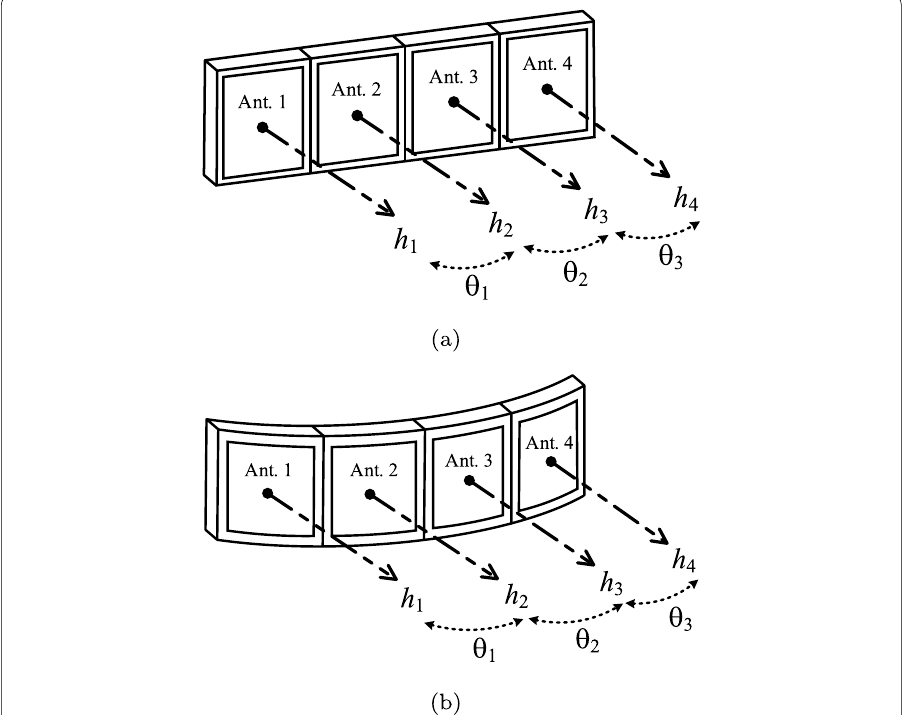
Fig. 4 Phase difference between adjacent antenna elements: a ULA, b